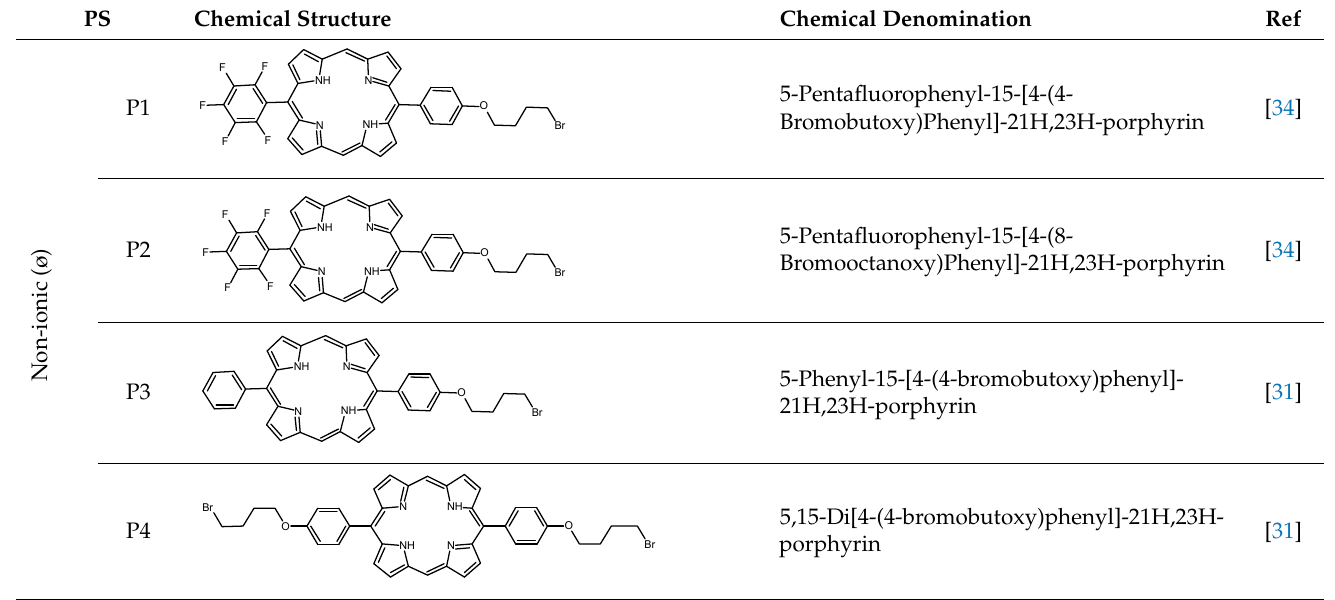
Table 1. List of diaryl-porphyrins (P1-P13) used in this study.